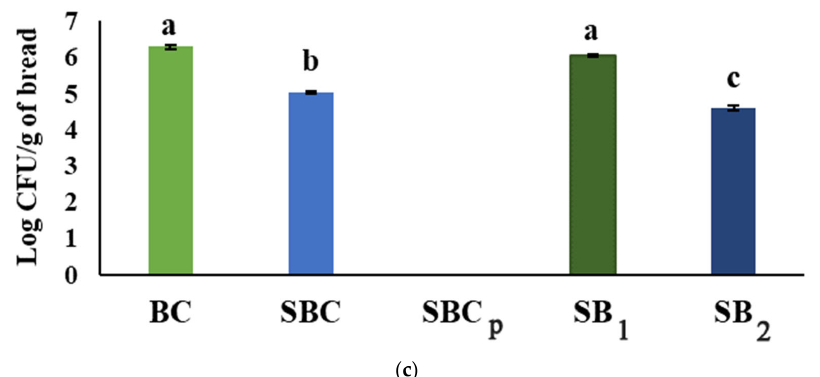
Figure 5. Fungal population in log CFU/g of bread. ( a ): A. flavus ; ( b ): P. commune ; ( c ): P. verrucosum . BC: bread control; SBC: sourdough bread control; SBC p : sourdough bread control with propionate; SB 1 : sourdough bread with L. plantarum 5L1 inoculum (0.5%); SB 2 : sourdough bread with L. plantarum 5L1 inoculum (5%). Different lower ‐ case letters indicate significant differences between treatments at the same time ( p ≥ 0.05).